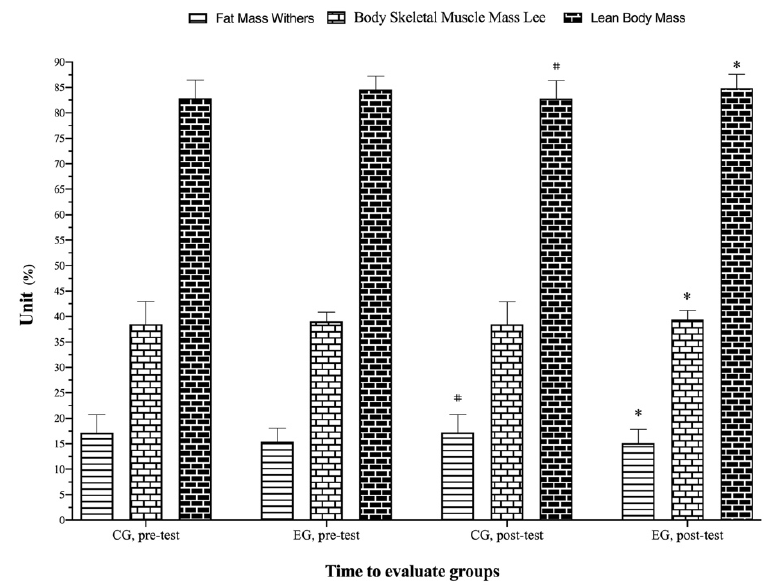
Figure 7. Change in body composition variables assessment for each group and assessment stage. * Represents a statistically significant difference compared to the pre-test with the superiority of